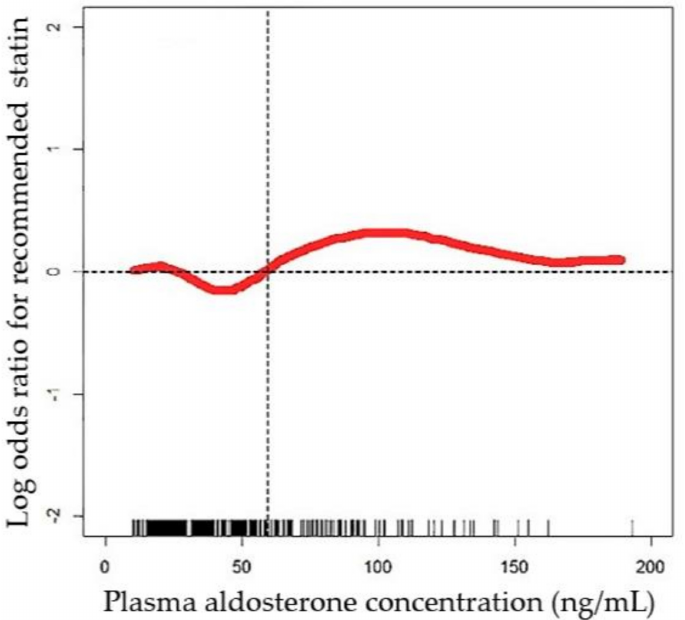
Figure 2. Generalized additive model (GAM) plot showing the recommendations for statin use by the 2013 ACC/AHA guidelines against plasma aldosterone concentration, incorporating the subject-specific (longitudinal) random effects. The probability of statin treatment was constructed with aldosterone level and was centered to have an average of zero over the range of the data as constructed with the GAM. Abbreviations: GAM, generalized additive